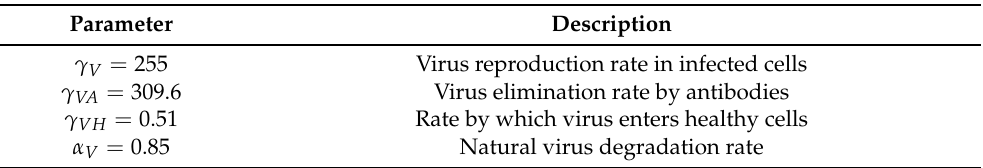
Table 2. The parameters of the in-host SARS-CoV-2 infection model. Parameter values are vali- dated by comparison with clinical COVID-19 testing [20,21]. A brief description of the parameters is given.